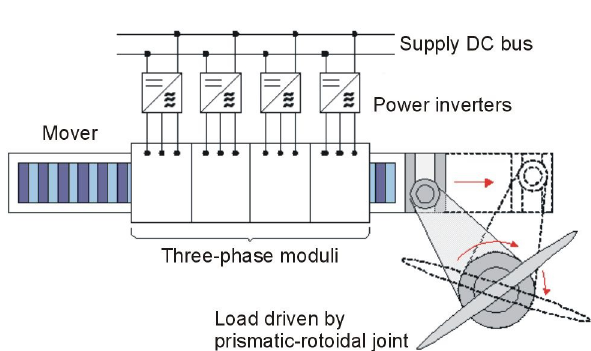
Figure 3: Transformation of the movement of translation into a rota- tion to drive the rudder